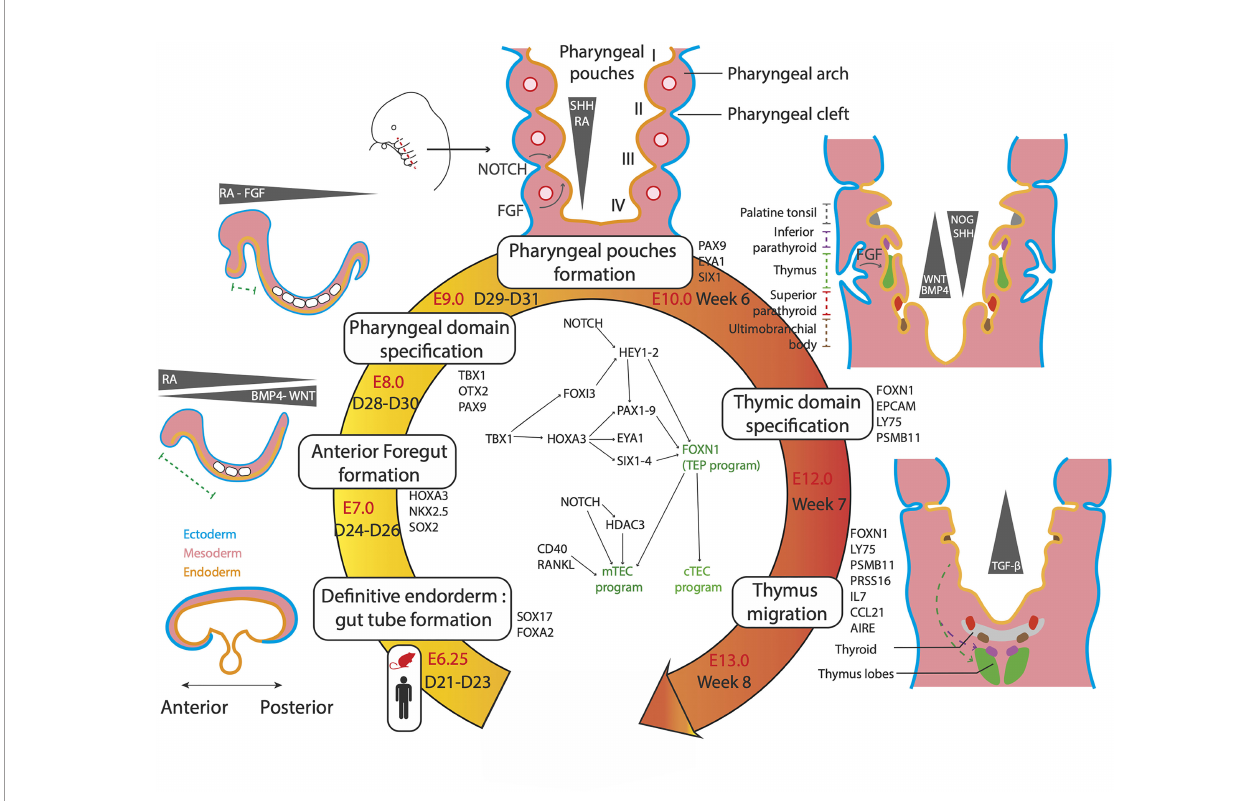
FIGURE 2 | Genetic and molecular networks regulating the thymus organogenesis. The thymus is a de fi nitive endoderm derivative. The main steps of organogenesis of the pharyngeal apparatus and thymus formation are described, with time scales in mouse and human, key markers genes and signalling molecules. First, gradients of cytokines and small molecules pattern the endoderm, resulting in an anterior domain between D24-D26 in human. Further patterning results in formation of the pharyngeal domain and its segmentation in pharyngeal arches at 6 weeks. The 3PP forms under singling involving retinoic acid (RA), Hedgehog (SHH), NOTCH and fi broblast growth factors (FGF). 3PP gives rise to the thymic primordium expressing FOXN1 by week 7. By week 8, the thymic primordium migrates under TGF b signaling to its fi nal position and TEC mature in cTEC and